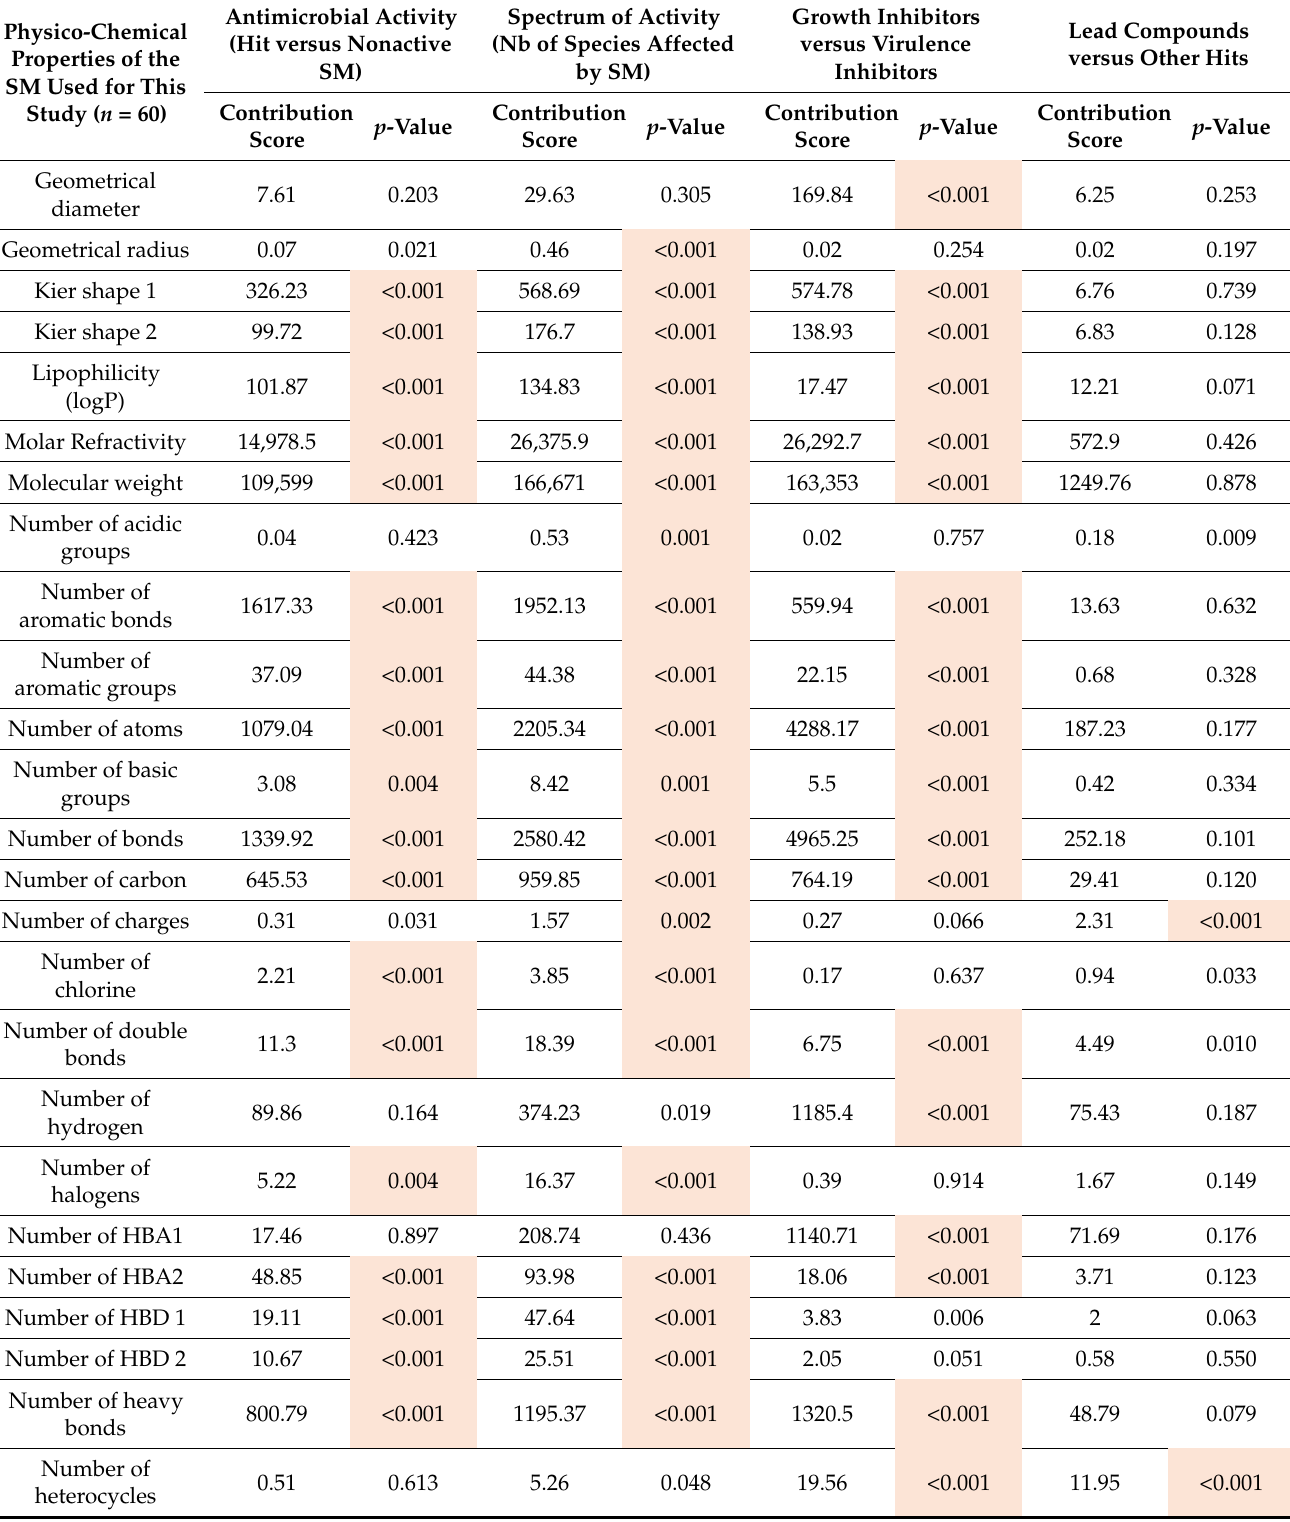
Table 4. Impact of the physico-chemical properties of the pre-selected library on the antimicrobial activity of the small